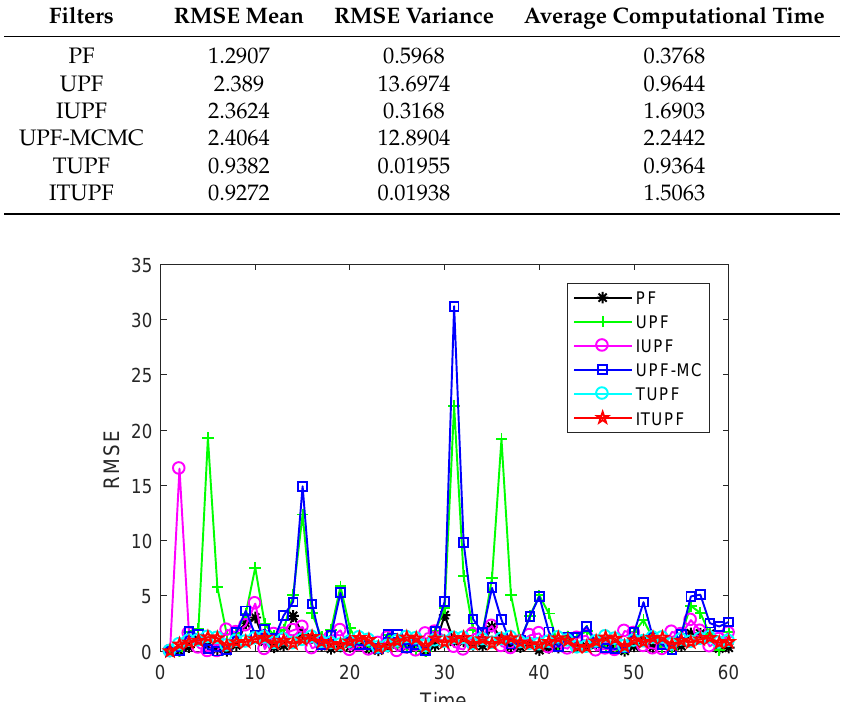
Figure 3. Root mean square error (RMSE) of different particle filters over 100 Monte Carlo